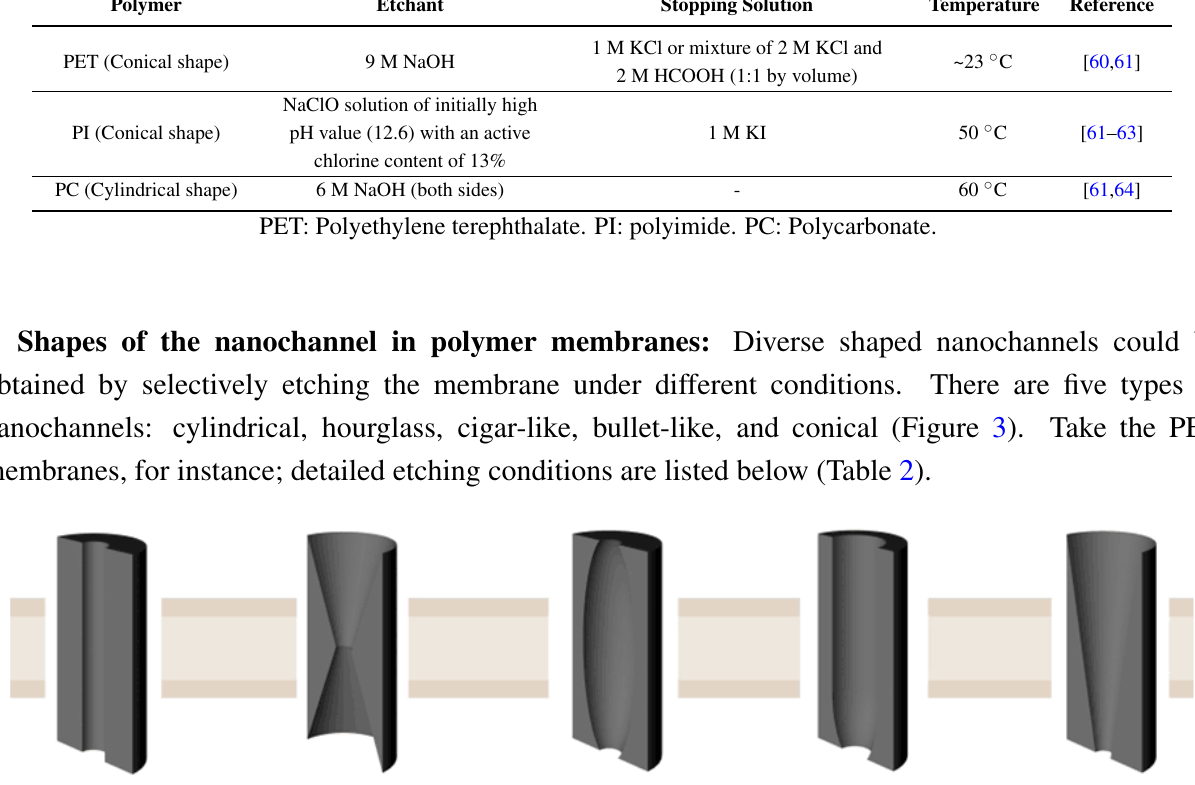
Table 1. Conditions of etching polymer membrane.